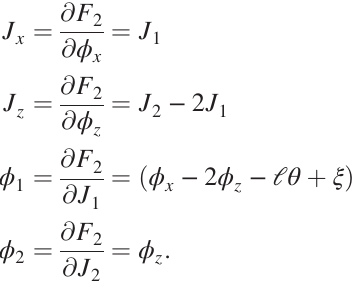
; 0 ; 3 ; 0 ; 4 ) and tracking method ana